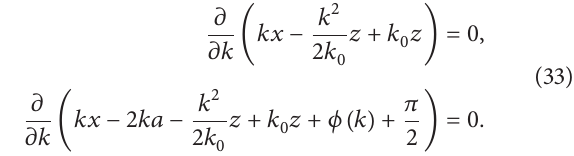
Table1:Propagationconstantvalues 𝜀 correspondingtothe 17 leaky modes supported by a slab of width 𝑘 0 𝑎 = 30 and constant refractive index 𝑈 0 = 1.5 .